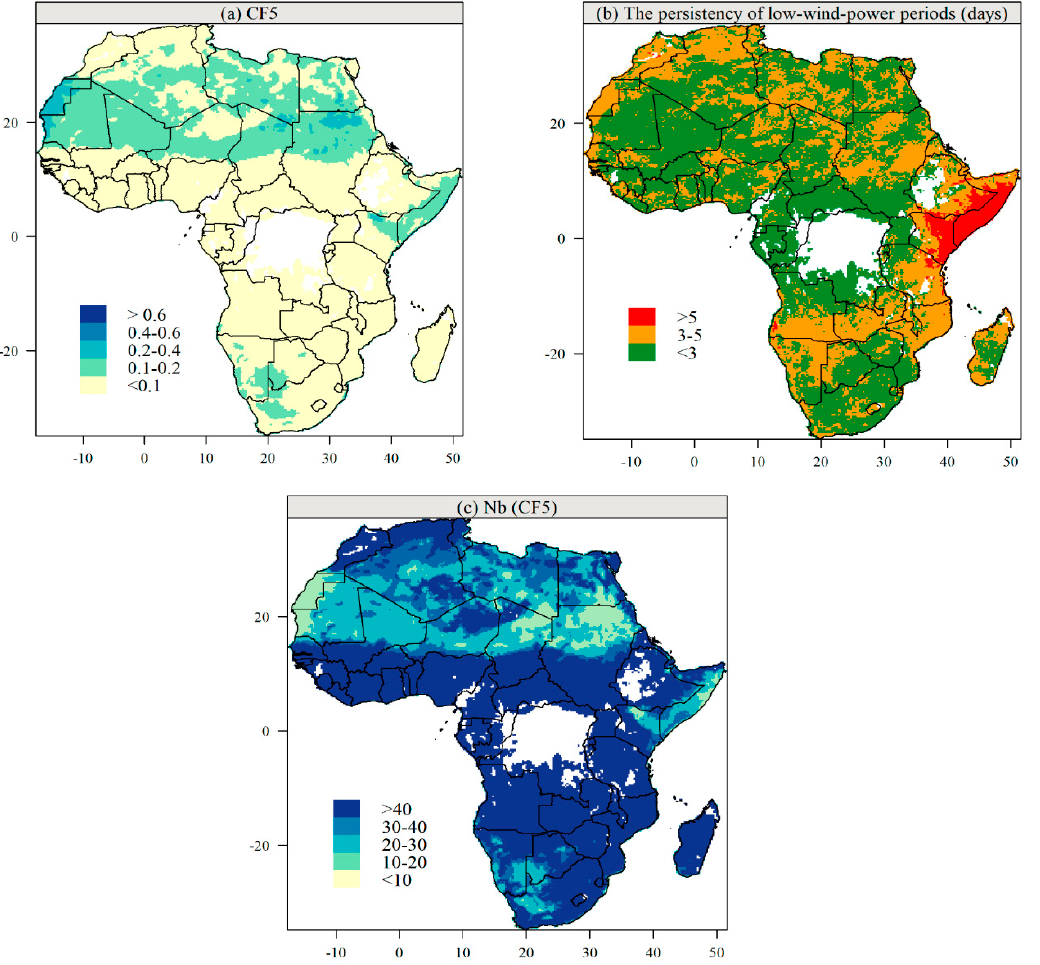
Figure 6. Low-wind-power days: ( a ) the fifth percentile of daily capacity factor for the 2000–2017 period (CF5); ( b ) the persistency of low-wind days; ( c ) the number of 30 kW wind turbines required to meet a constant 100 kW demand in at least 95% of days of the year (Nb (CF5)). The areas for which the fifth percentile of daily capacity factor is zero are masked (white color).